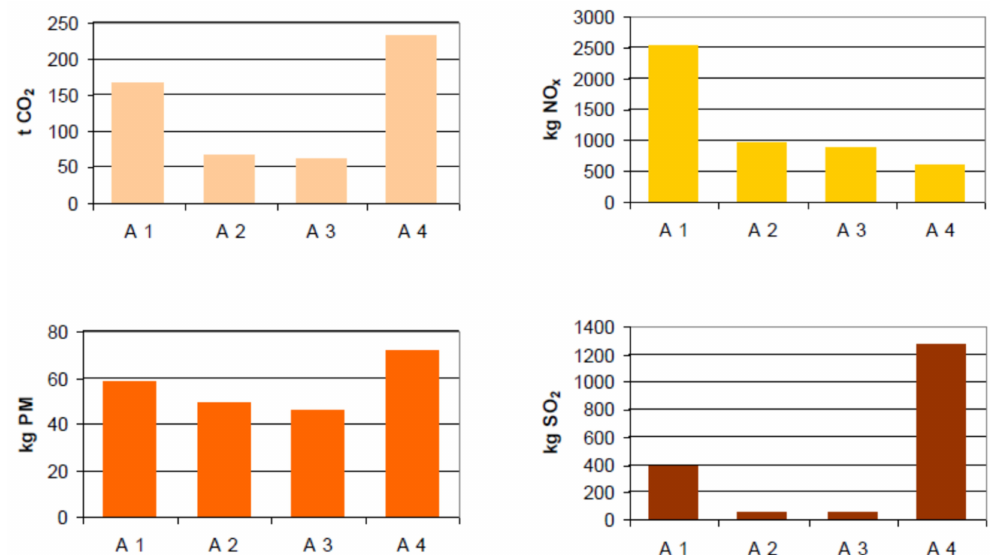
Figure 6. Modelling the differences in air pollution between four different transport alternatives (A1 road transport, A2 and A3 inland waterways, A4 railway), inland waterways (options A2 and A3) appear to be the most environment friendly. The high level of emissions for rail transport is due to fossil fuel-based power plants for electric traction